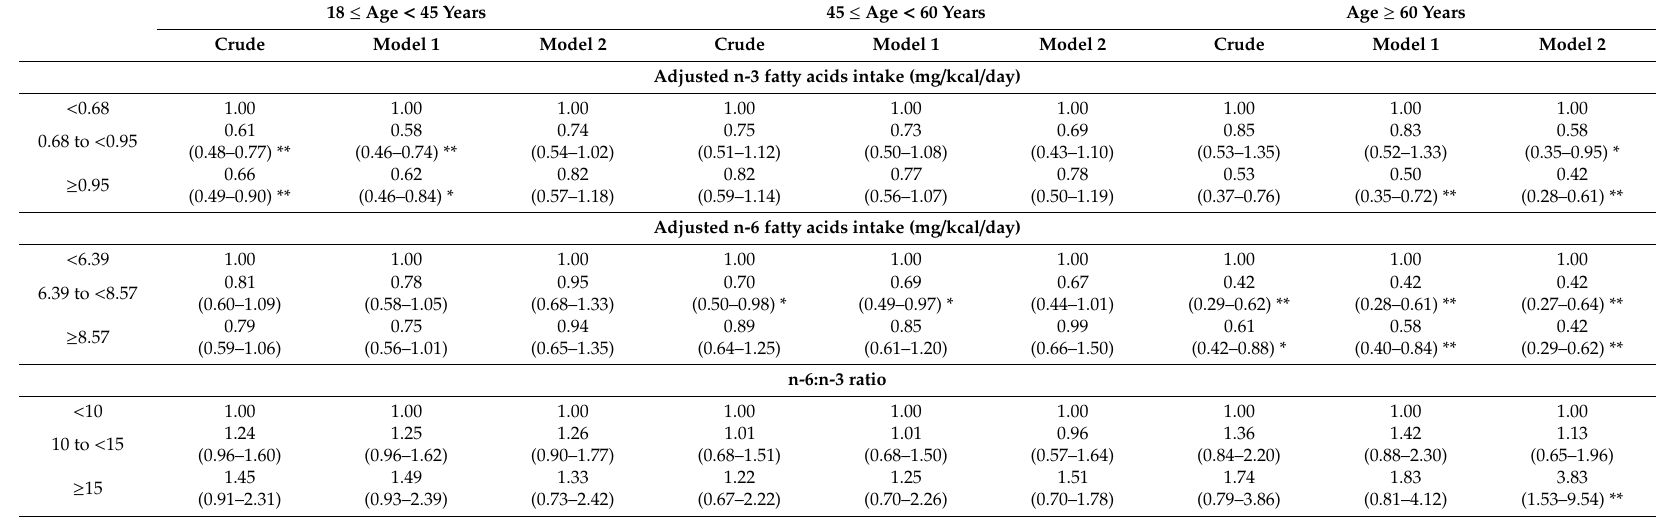
Table 3. The ORs (95%CIs) of depressive symptoms by adjusted dietary n-3 and n-6 fatty acid intakes and n-6:n-3 ratio, stratified by age, NHANES 2009–2016 ( n =